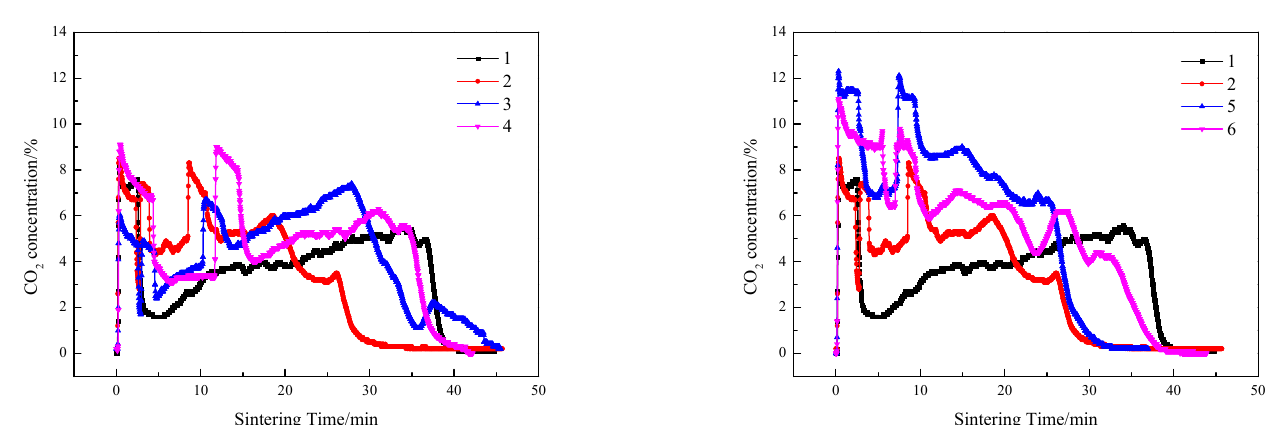
Figure 7. NO x emissions of sintering flue gas at different ignition time intervals and layer height proportions.